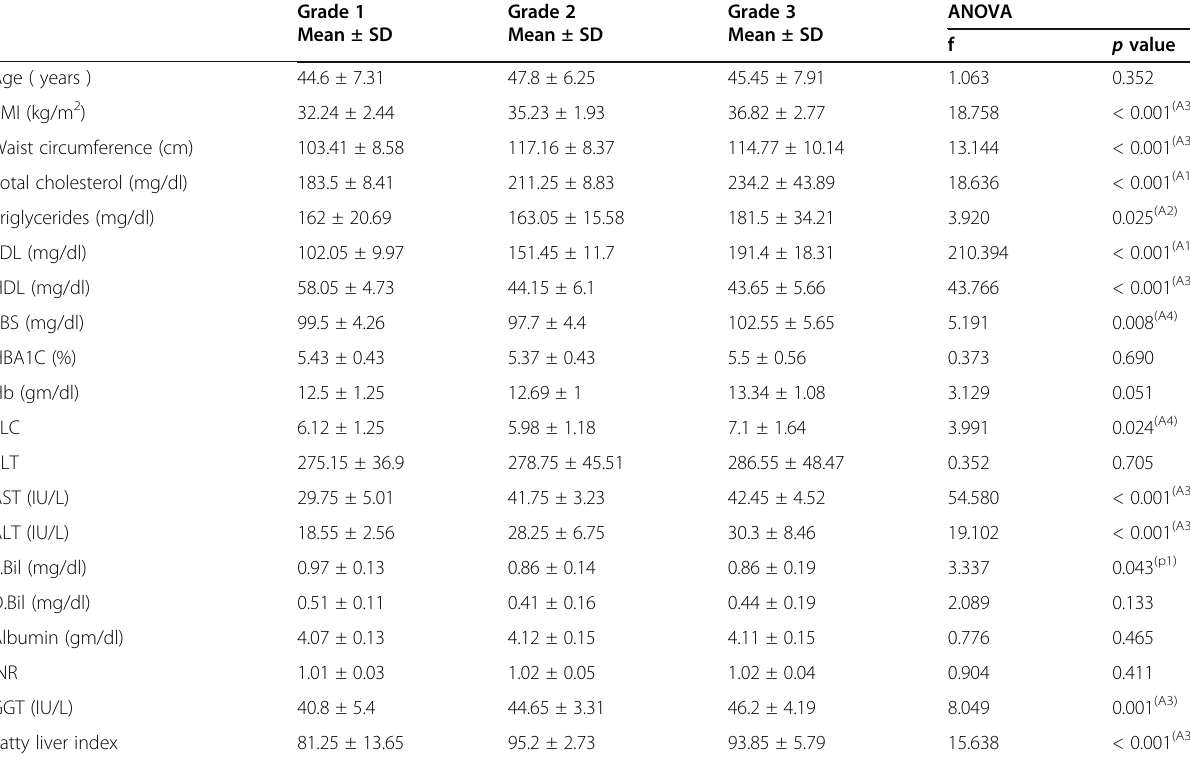
Table 3 Comparison between the 3 grades of